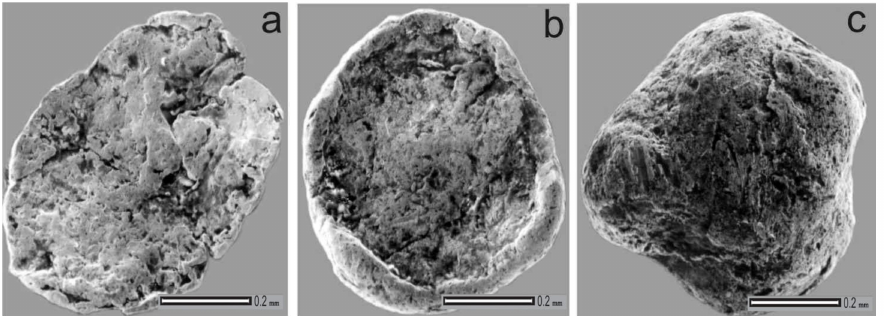
Figure 12. The sequence of the transformation of natural flake gold particles in aeolian conditions (the East Siberian platform, the size is 0.25 mm). Stages of transformation: ( a ) initial (flake with thin, ridgelike edges; ( b ) middle (toroidal shape); ( c ) final (hollow spherical